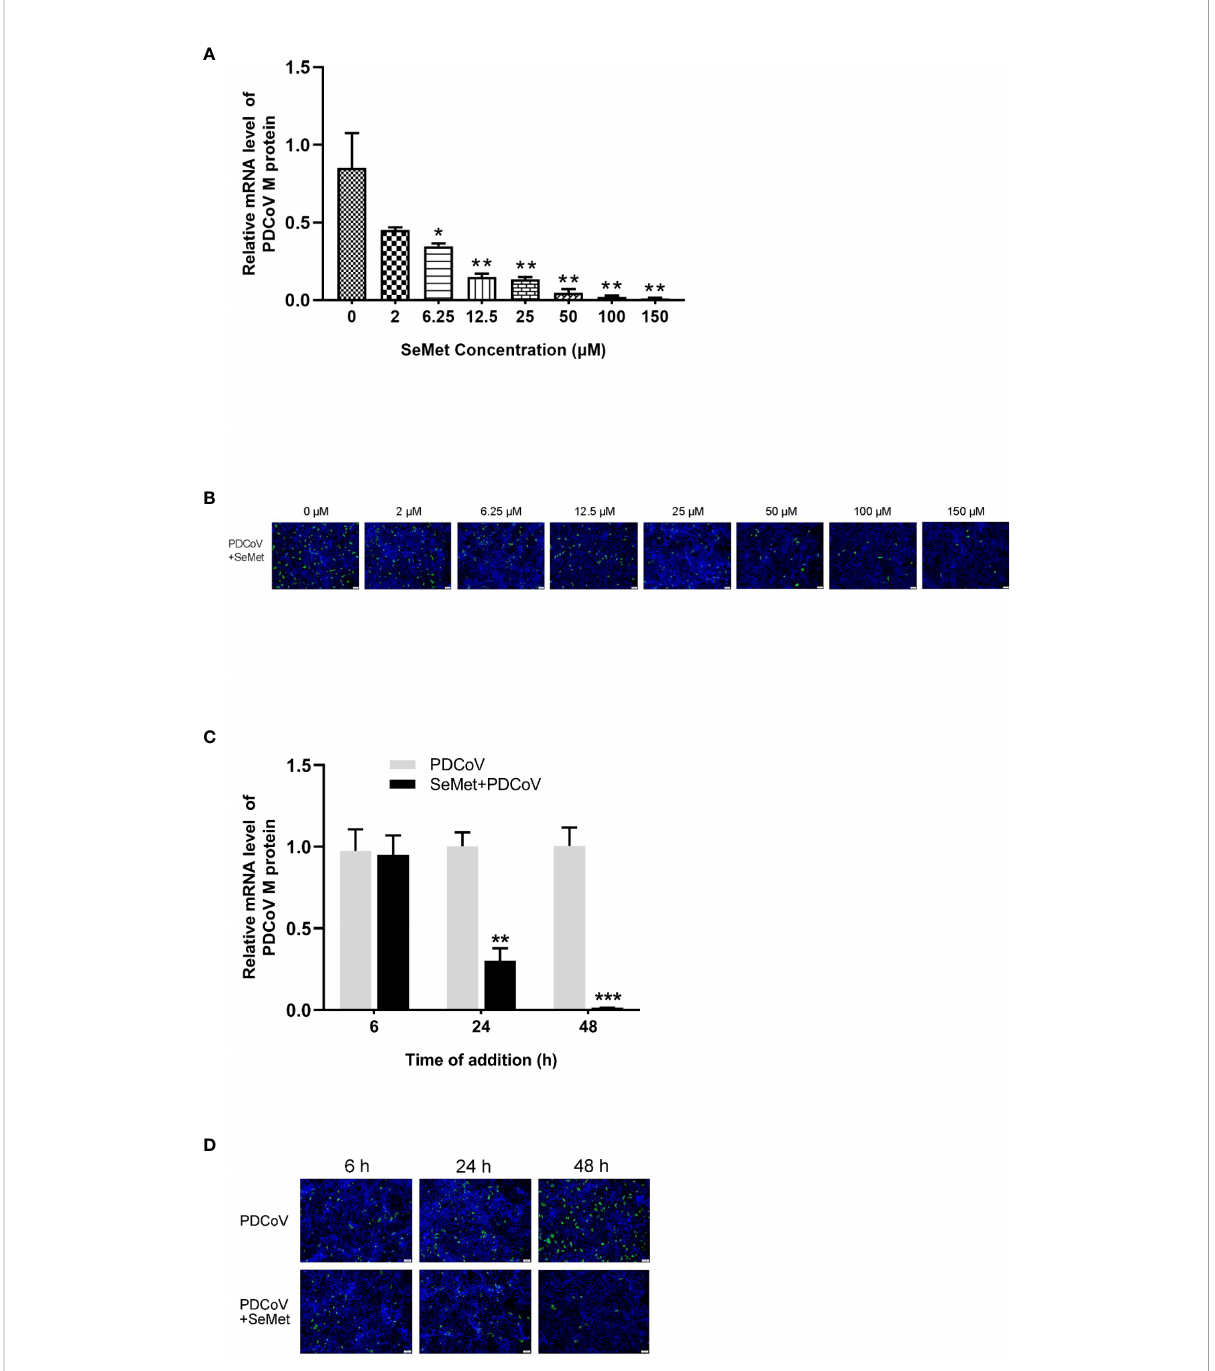
FIGURE 1 SeMet inhibits the infectivity of PDCoV. (A) LLC-PK1 were infected with PDCoV (100 TCID 50 = 10 -2.15 ) for 1.5 h and treated with 0~150 m M of SeMet. Cells were collected after 48 h for qRT-PCR of viral M gene (n=6). (B) At 48 h treatment with SeMet, PDCoV (100 TCID 50 ) replication in LLC-PK1 cells was determined by indirect immuno fl uorescence assay (IFA). (C) LLC-PK1 cells were infected with PDCoV for 1.5 h and treated with SeMet (150 m M) for 6, 24, and 48 (h) Expression level of viral mRNAs was analyzed by qRT-PCR (n=6). (D) At 6~48 h treatment with SeMet, PDCoV replication in LLC-PK1 cells was determined by IFA. Means ± SD are shown. Statistical signi fi cance was determined by Student t test. ***, P <0.001; **, P <0.01; *, n.s, not signi fi cant. All experiments were repeated at least twice and representative results are